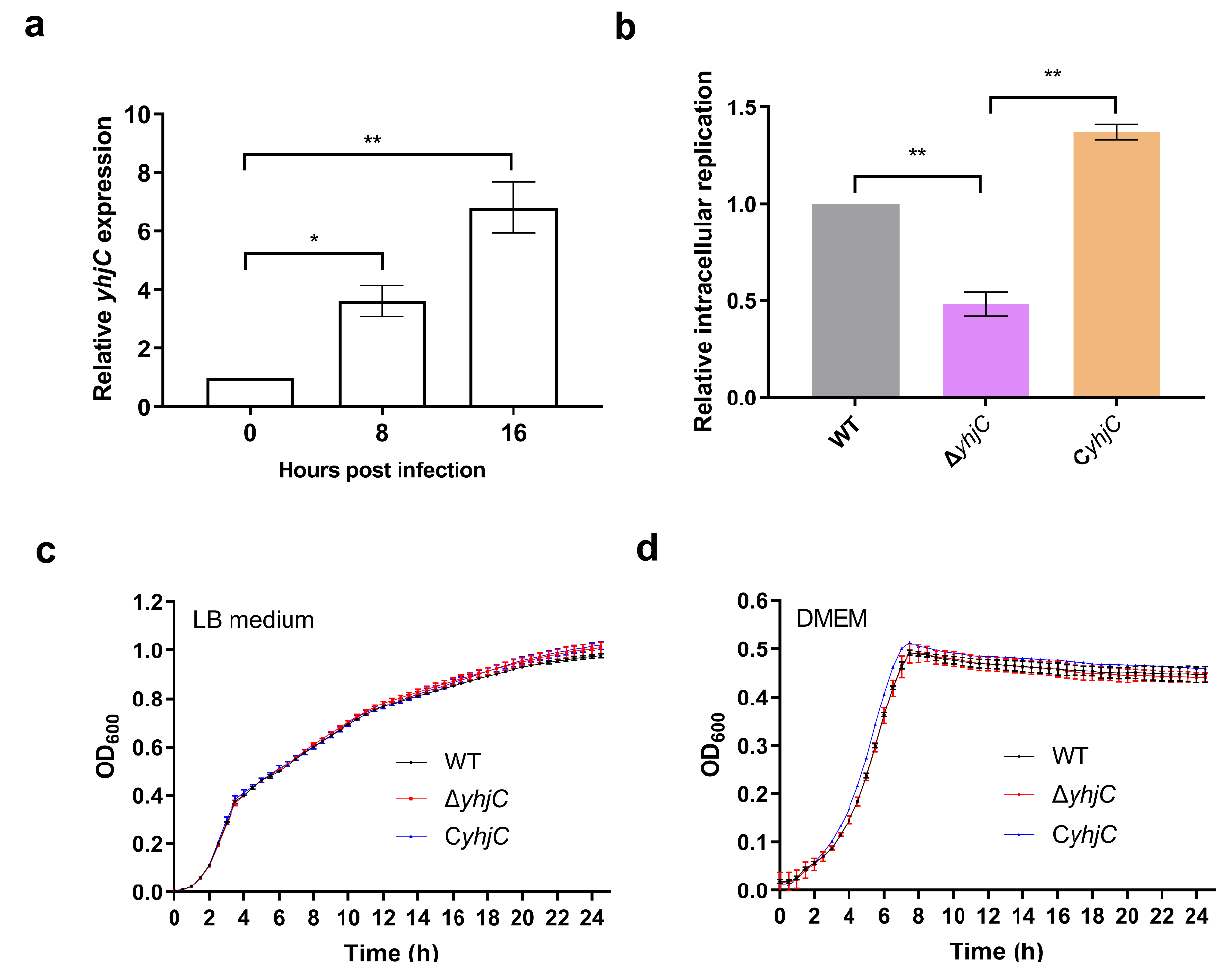
Figure 1. Deletion of yhjC reduced the replication ability of S. Typhimurium in RAW 264.7 cells. ( a ) Relative expression of yhjC gene of S. Typhimurium before and after entering 264.7 cells, where 0 represents the gene expression of S. Typhimurium cultured in DMEM medium for 8 h. ( b ) Fold replication of S. Typhimurium WT, Δ yhjC (yhjC mutant), and C yhjC (complemented strain) in RAW264.7 cells at 16 h post-infection. ( c , d ) Growth curves for S. Typhimurium WT, Δ yhjC , and